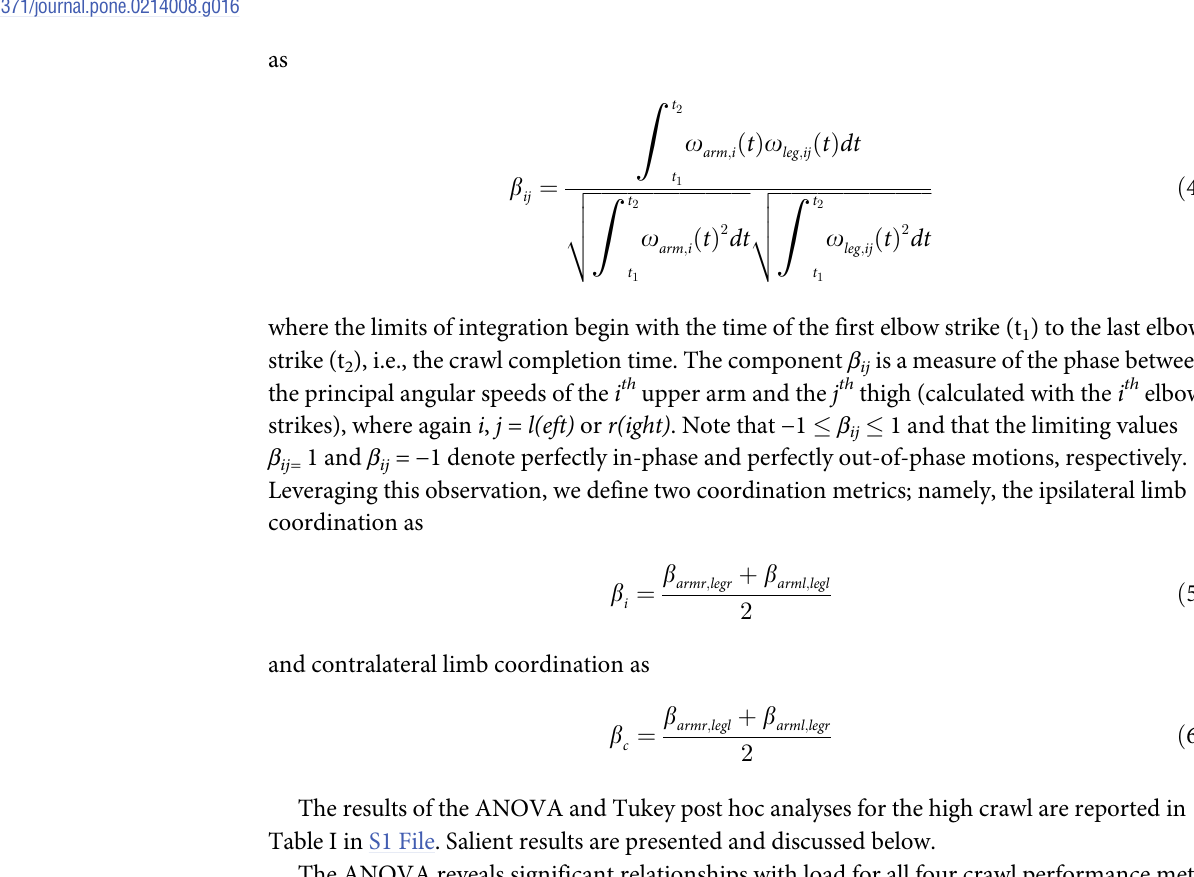
ffiffiffiffiffiffiffiffiffiffiffiffiffiffiffiffiffiffiffiffiffiffiffiffiffiffiffiffiffiffi Z